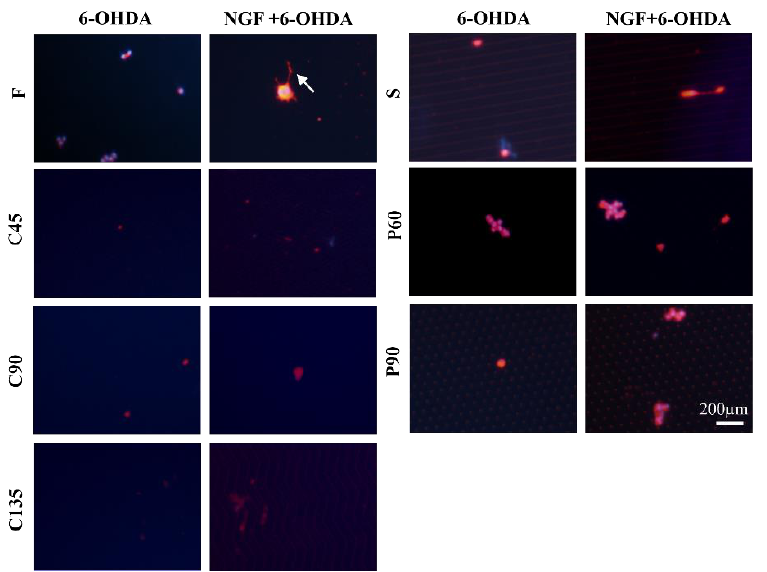
Figure 5. Fluorescence images of β -tubulin expression of PC12 cells under different conditions after 6-OHDA treatment. Red, β -tubulin; blue, cell nucleus; NGF: 100 ng/mL; 6-OHDA: 20 ng/mL. Scale bar = 200 µm.